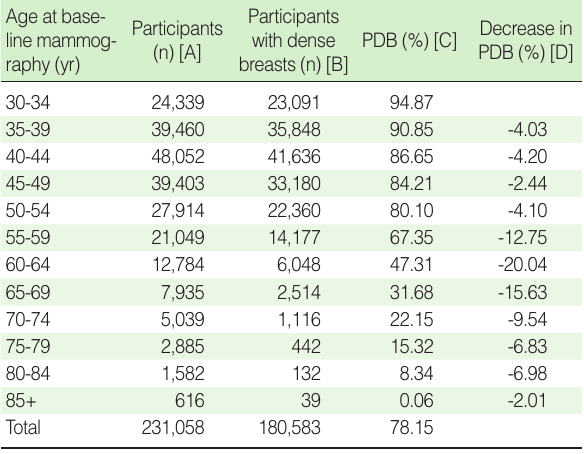
Table 1. The proportion of dense breasts (PDB) by age group 1